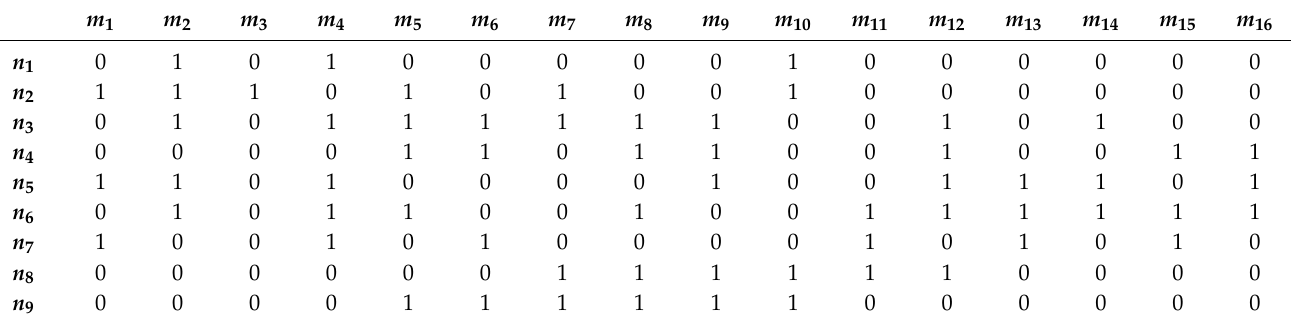
Table 11. Transport travel matrix for Variant #2.